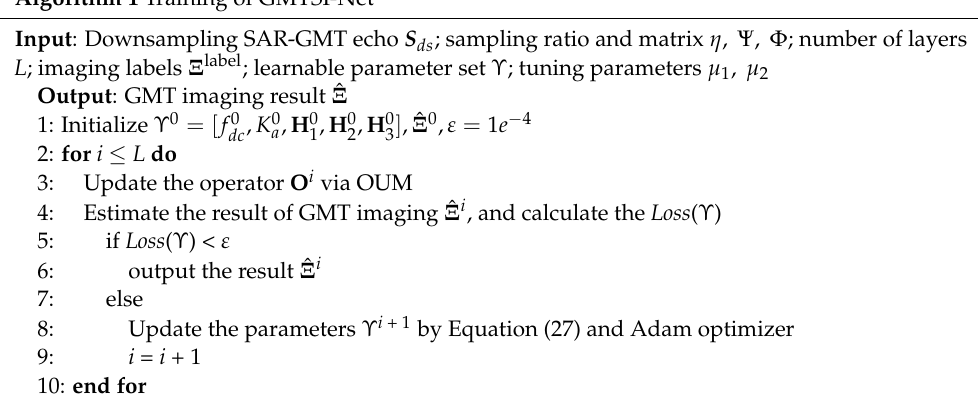
Algorithm 1 Training of